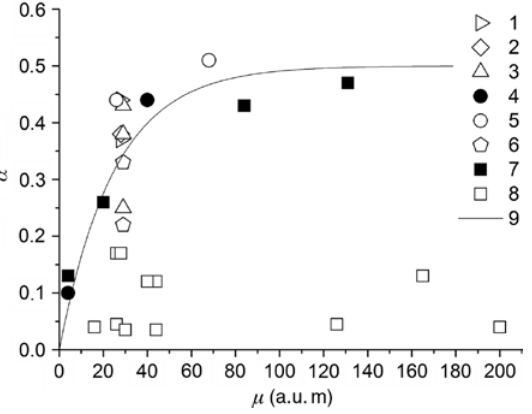
Figure 1: The measured values of the thermal accommodation coefficients of carbon NPs dependent on the molecular weight of bath gases. Closed symbols: data for the monoatomic gases, open symbols: data for the polyatomic gases. (1) data by Snelling et al. [27], (2) data by Krüger et al. [59], (3) data by Kuhlmann et al. [68], (4 and 5) data by Eremin et al. [81], (6) data by Maffi et al. [78], (7 and 8) data by Daun et al. [82], (9) best fit of monoatomic gas data by dumped exponential